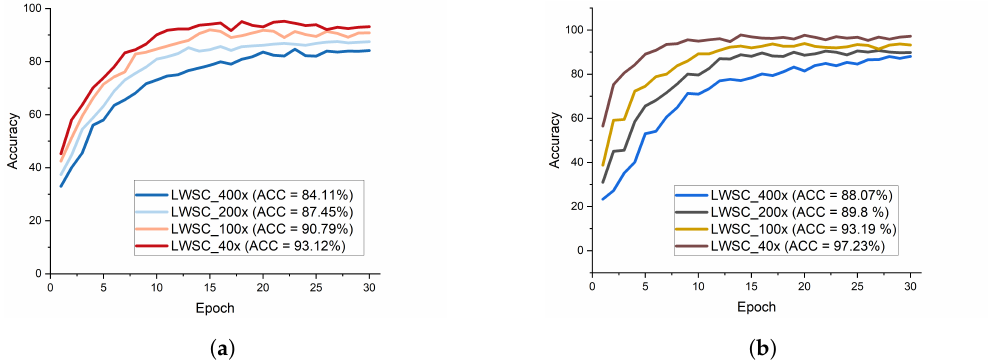
Figure 4. Accuracy performance report of the BC classification for both two classes and eight classes. ( a ) Test accuracy curve for different magnification factors for two classes of BC classification using the proposed model with contrast-enhanced images, ( b ) Test accuracy curve for different magnification factors for eight classes of BC classification using the proposed model with contrast-enhanced images. Table 3. Comparison of the proposed model with different pre-processing